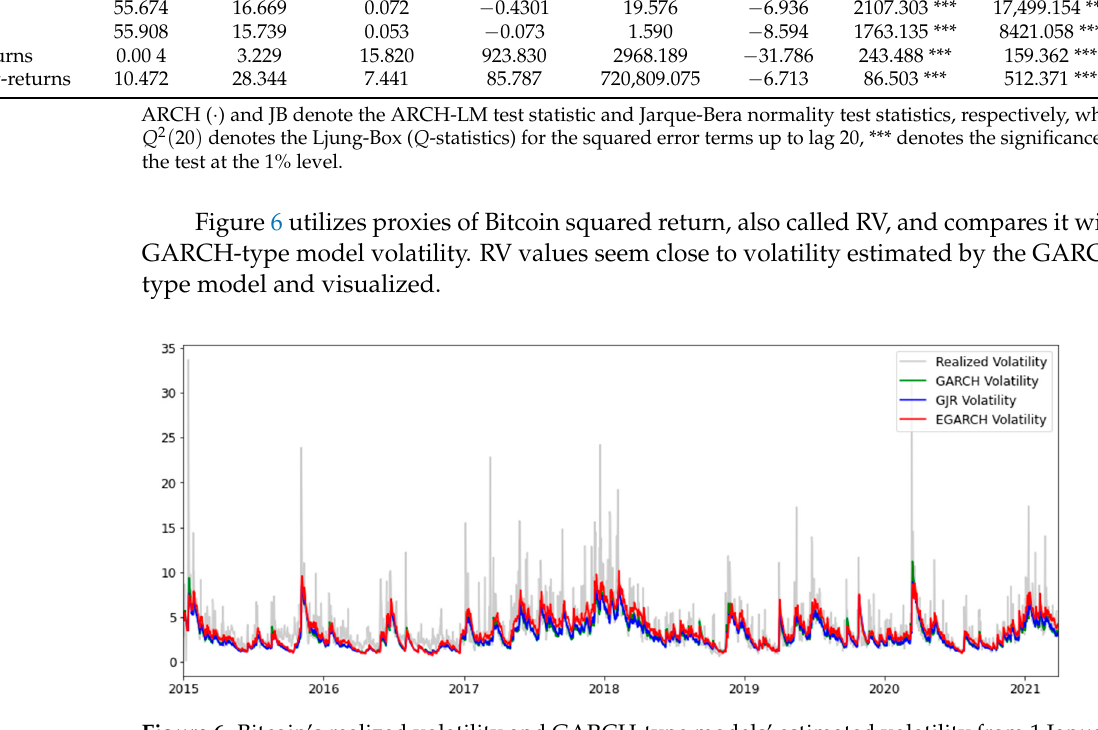
Figure 7. Bitcoin log-returns, Q-Q plot, autocorrelation, and partial autocorrelation plots. 4.1. Estimation Results Three GARCH-type models (GARCH, GJR, and EGARCH) were fitted to the in-sam- ple data and the results of the parameters estimates, along with their standard errors, are presented in Table 2. All three GARCH models’ estimated parameters were highly